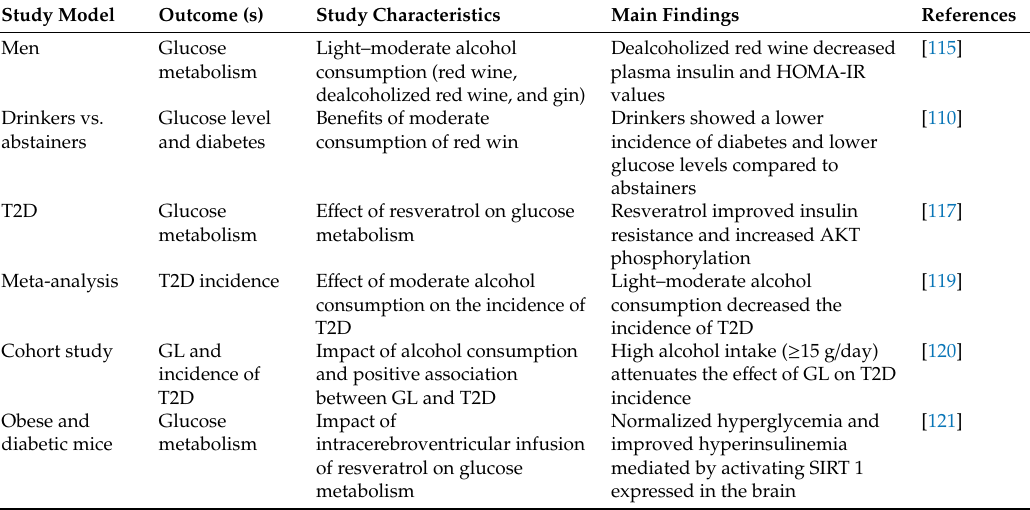
Table 3. Summary of studies assessing the impact of red wine consumption on glucose metabolism. HOMA-IR: homeostasis model assessment of insulin resistance, T2D: type-2 diabetes, GL: glycemic